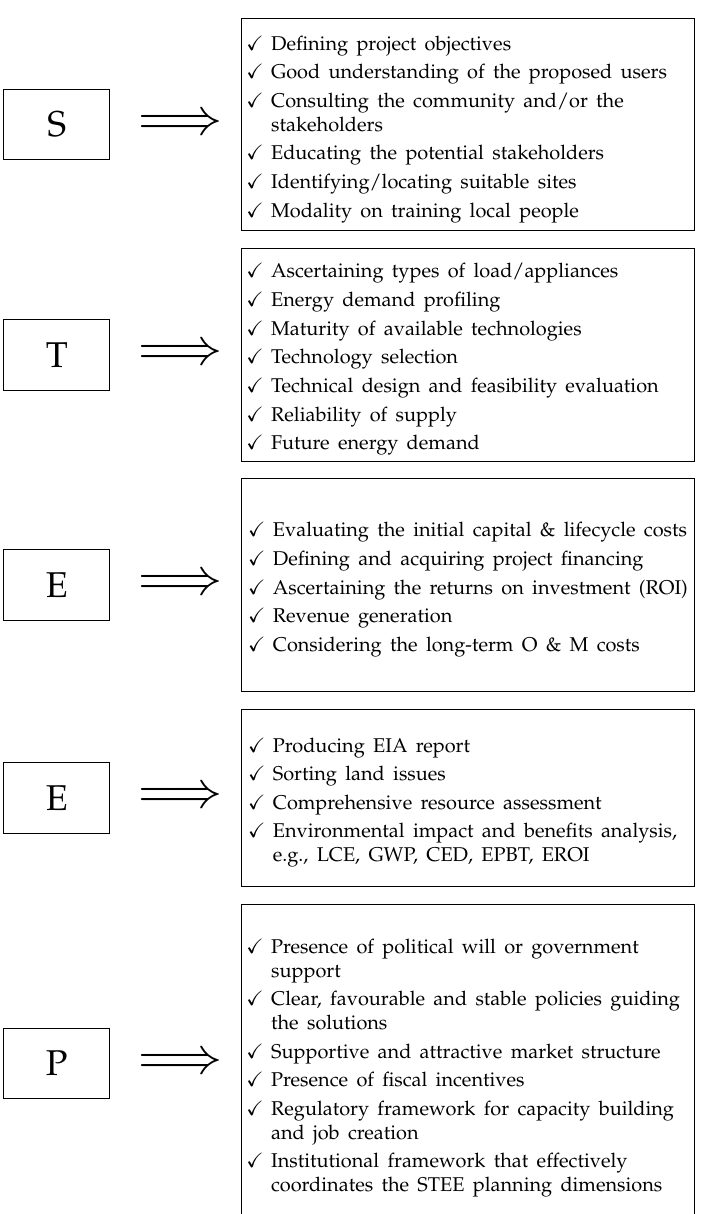
Figure 5. Sustainable planning